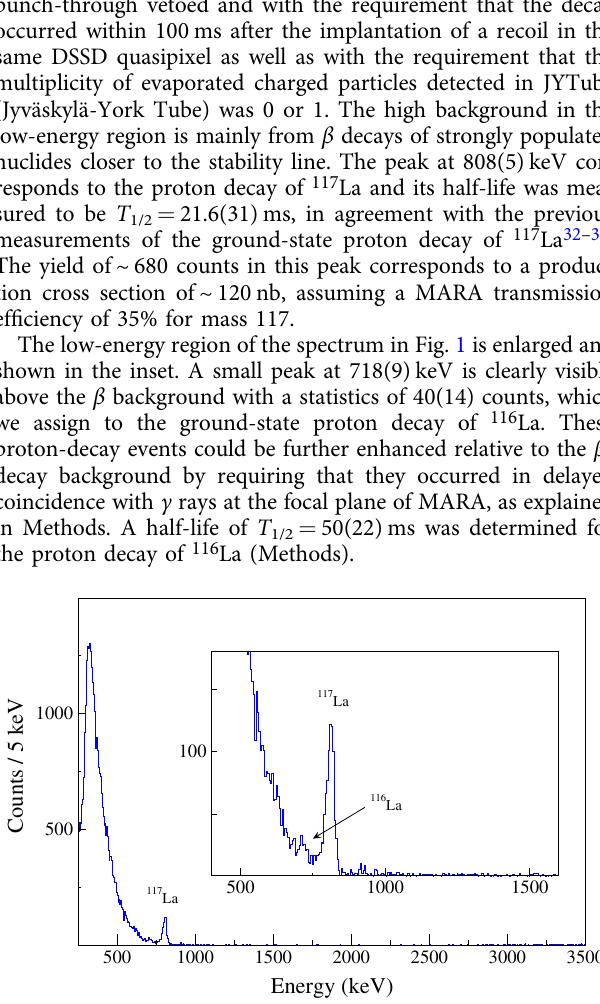
Fig. 1 Energy spectrum of punch-through-vetoed decay events. These events were measured in the DSSD within 100 ms after an ion implantation in the same quasipixel at the beam energy of 330 MeV. The inset shows the enlarged low-energy region. The previously known proton-decay peak of 117 La and the newly observed proton-decay peak of 116 La are